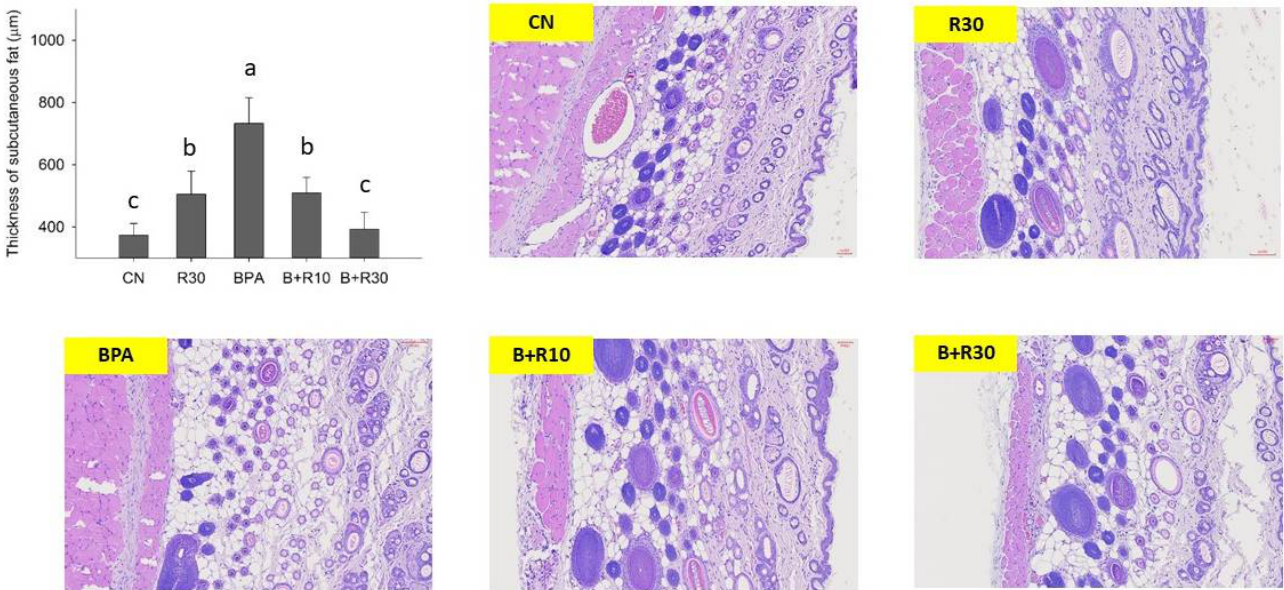
Figure 2. Representative images of subcutaneous tissue sections stained with haematoxylin and eosin (H&E) and examined under a microscope. a–c Values with different letters are specific to each group and show significant differences ( p < 0.05). CN = control group; R30 = group administered with 30 mg/kg/day of RBE; BPA = group administered 50 μg/kg/day of bisphenol A; BPA+R10 = group administered with 10 mg/kg/day of RBE and bisphenol A; BPA+R30 = group administered with 30 mg/kg/day of RBE and bisphenol A. Data are expressed as means ± SD ( n = 4–8).